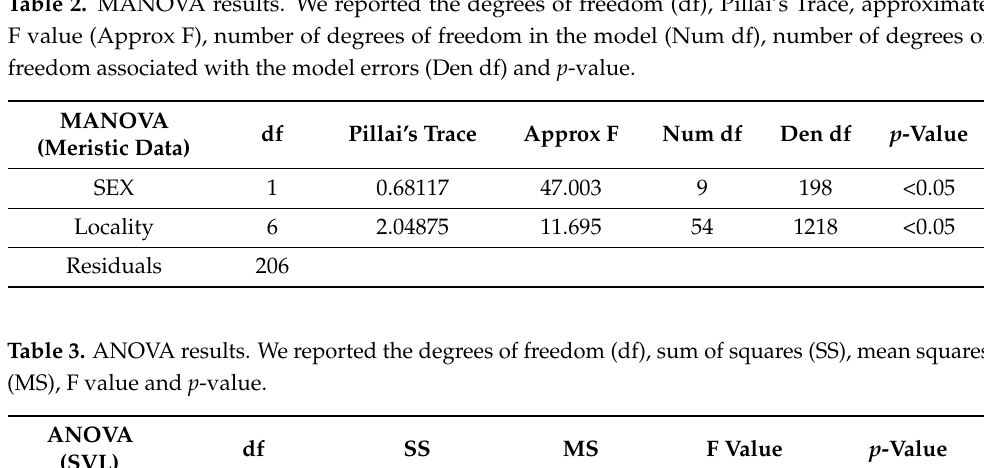
Table 3. ANOVA results. We reported the degrees of freedom (df), sum of squares (SS), mean squares (MS), F value and p -value.